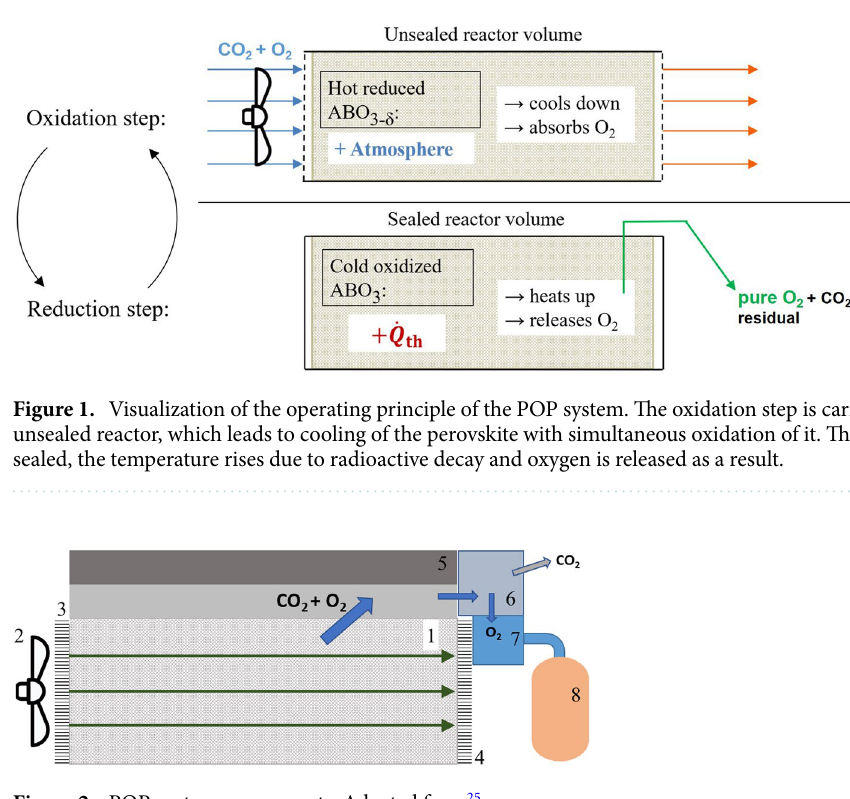
Figure 2. POP-system components. Adapted from 25